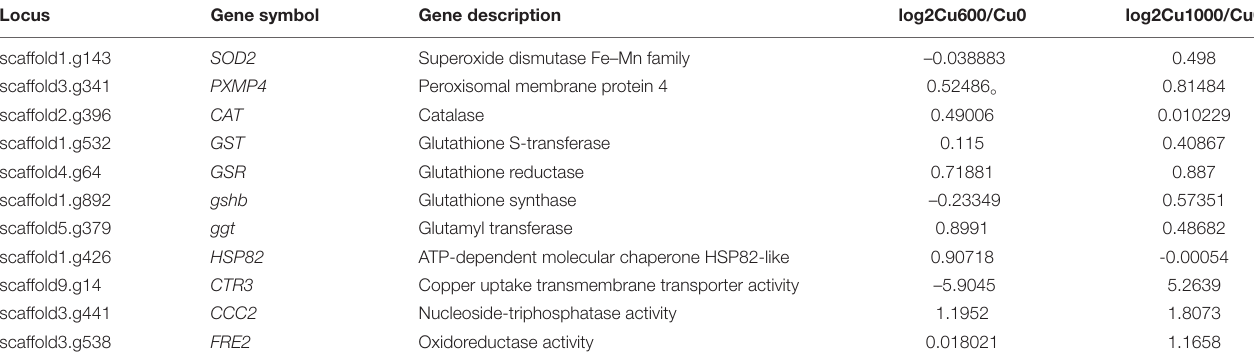
TABLE 2 | Annotation results of genes relevant to Cu 2 + tolerance in M. guilliermondii GXDK6. Locus